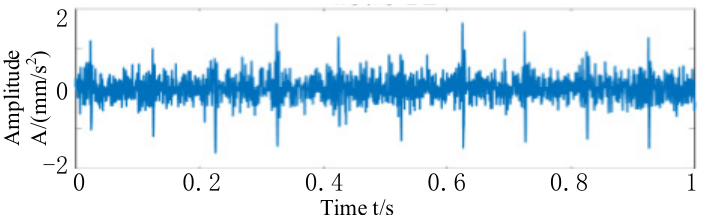
Figure 9. Time-domain waveform diagram of a synthesized signal with the harmonic components removed when sparsity K = 7.